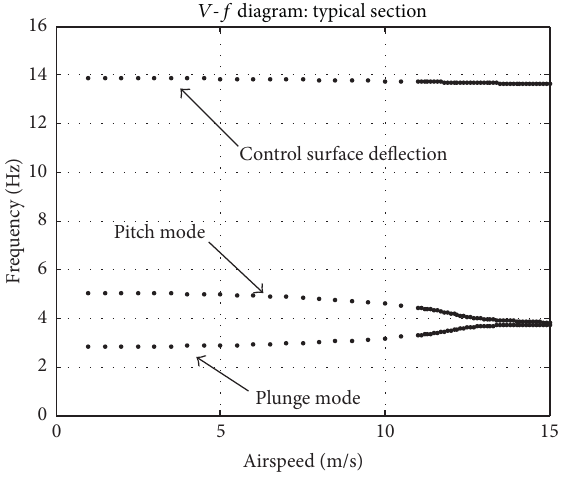
Figure 5: Linear flutter analysis: 𝑉 - 𝑔 diagram.